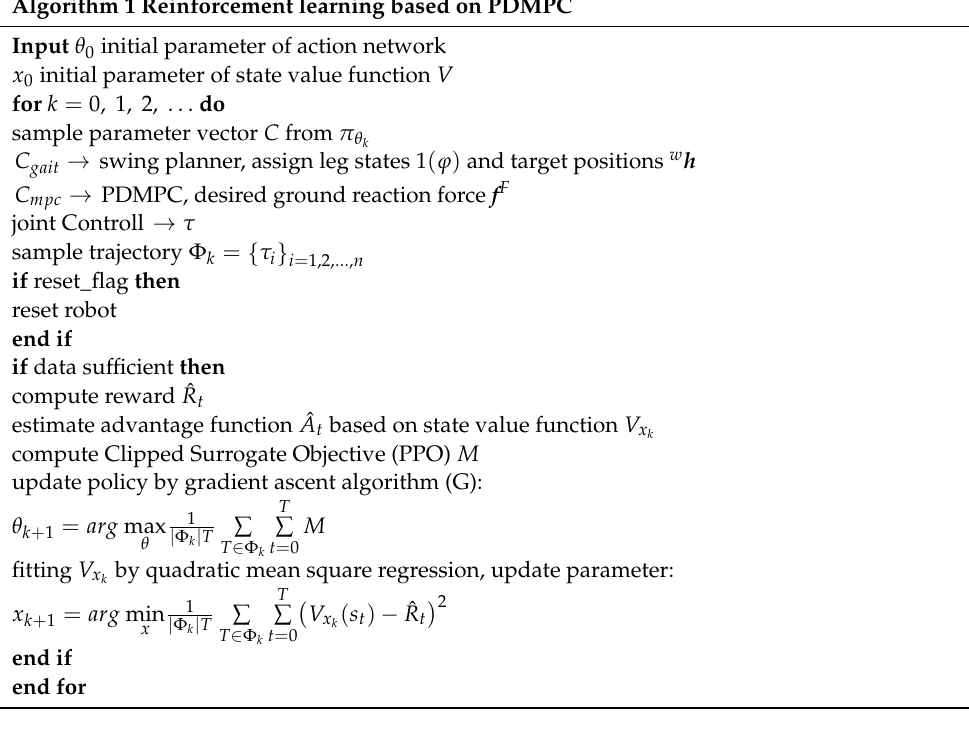
Algorithm 1 Reinforcement learning based on